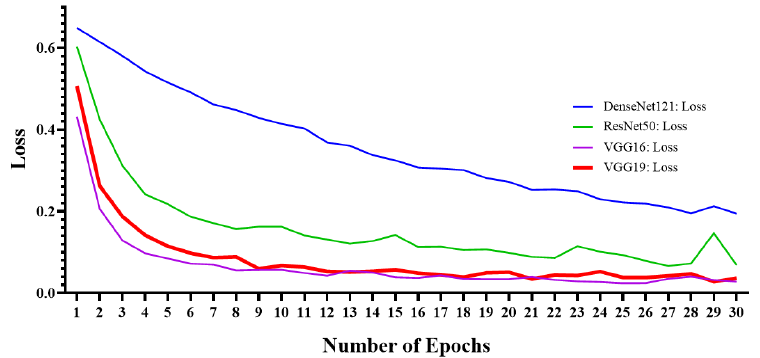
Figure 3. Training accuracy curve for DenseNet121, ResNet50, VGG16, and VGG19. Information 2020 , 11 , x FOR PEER REVIEW